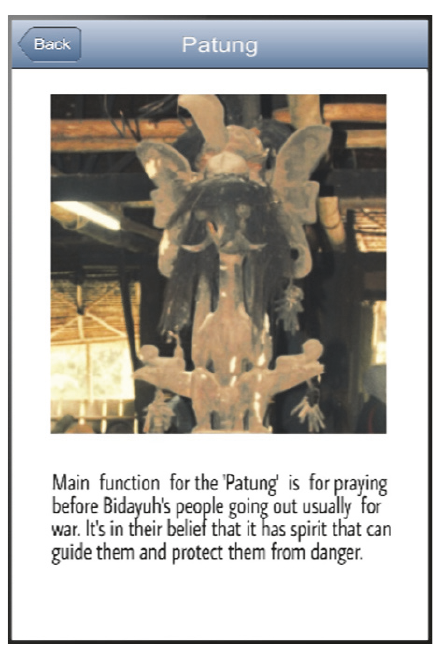
Figure 10: The information about the selected